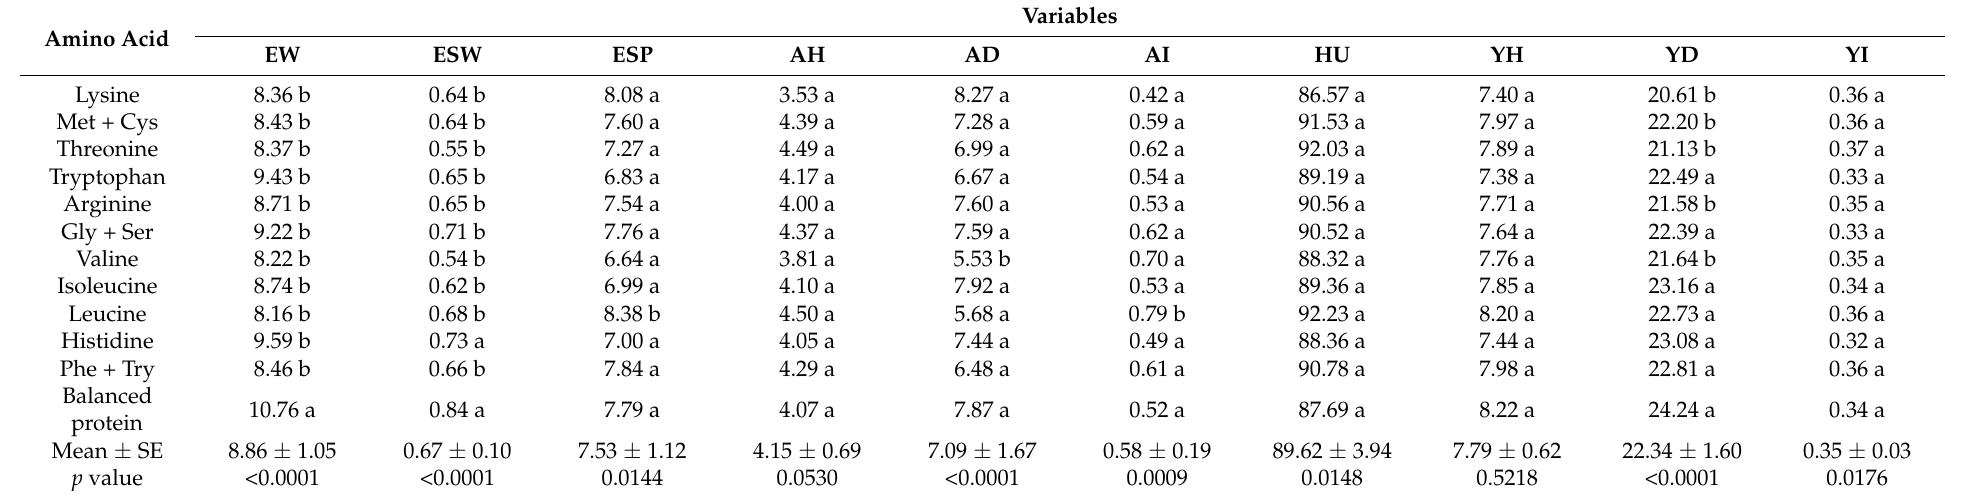
Table 5. Effects of the dietary amino acid limitation on the egg quality of Japanese quail